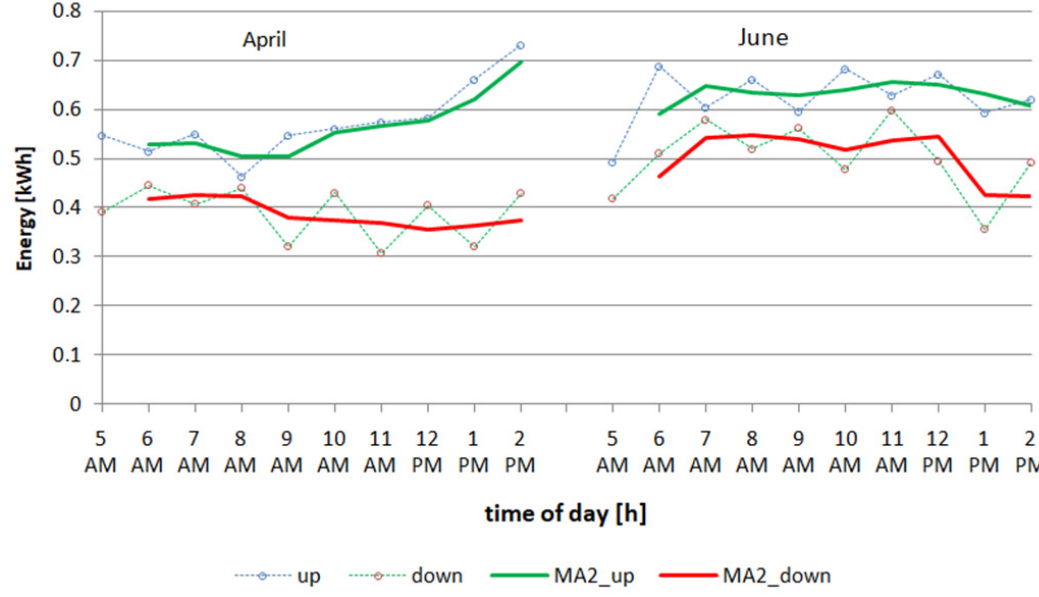
Figure 3. Energy consumption for trip between stops in both directions (up and down).